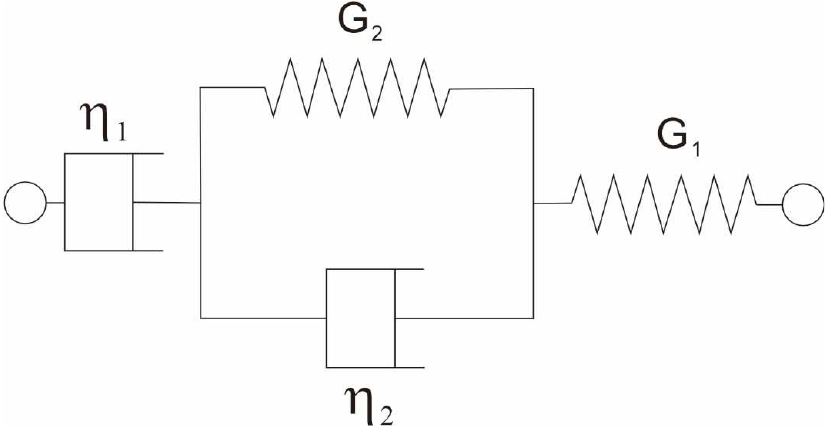
Figure 12. Burgers model. Figure 12. Burgers